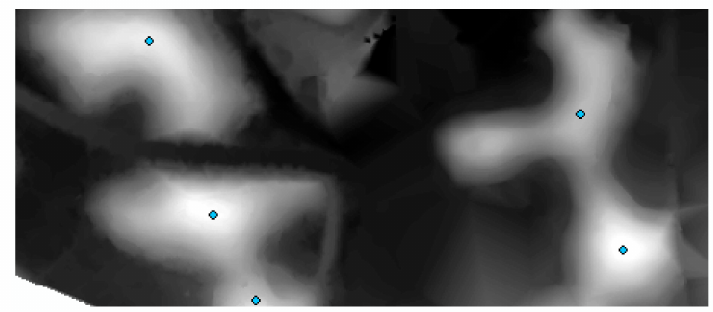
Figure 13. The distribution map of the second dataset extracted using the reference method.